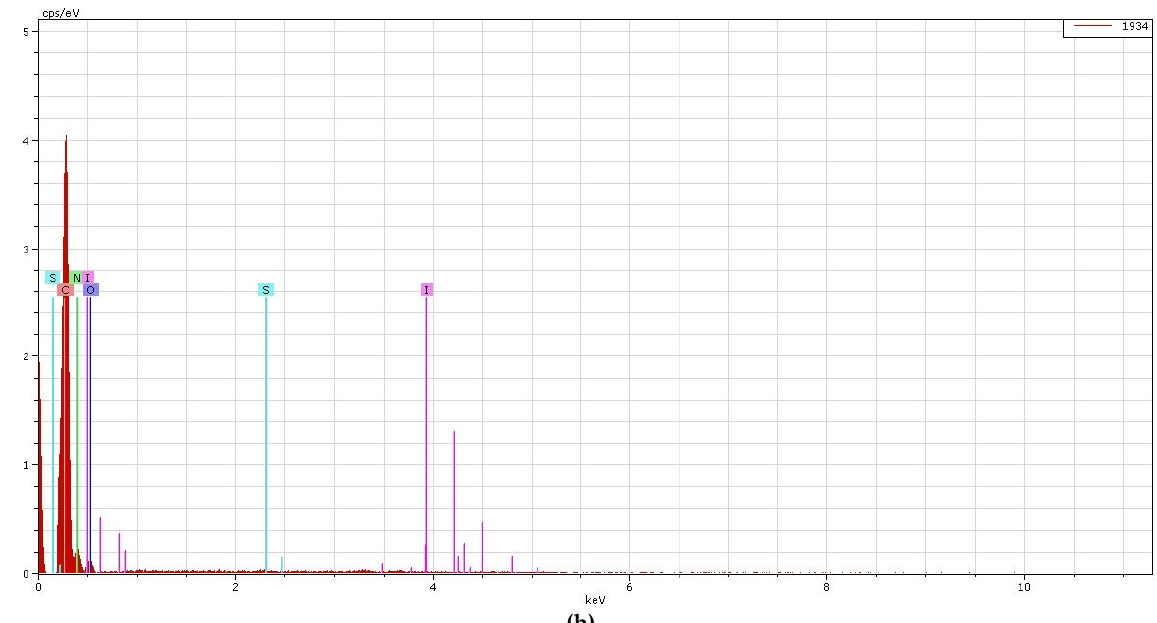
Figure 10. EDX spectrum of element analysis for Dralon L fibers: ( a ) untreated, and ( b ) after functionalization.